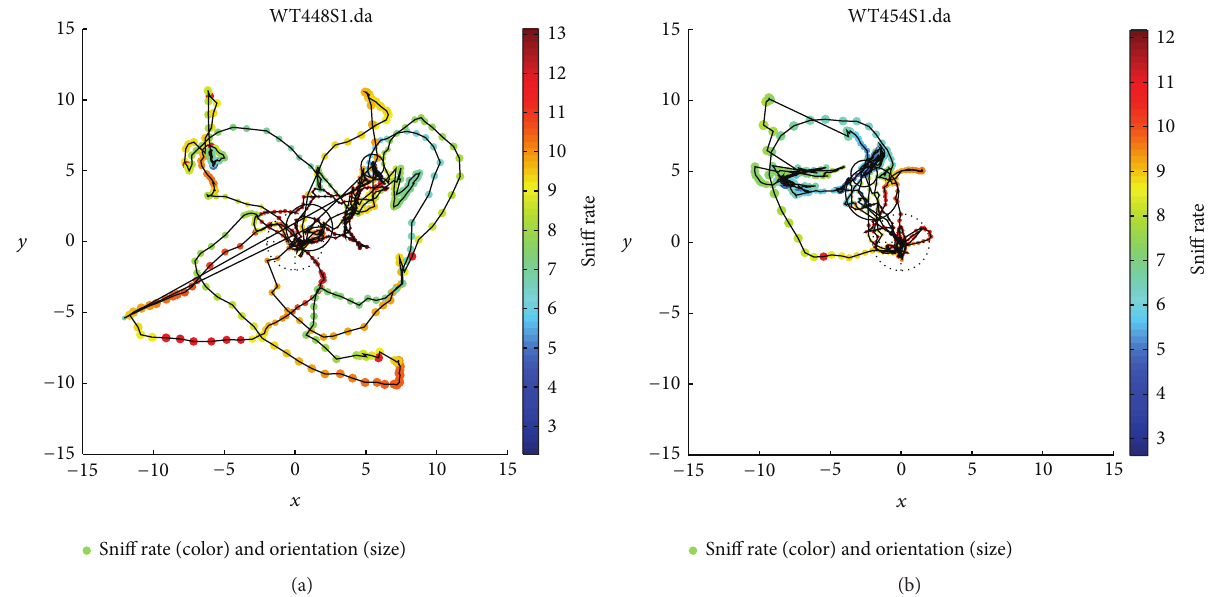
Figure 3: HaXha maps show sniffing rate related to proximity and orientation. Two S1 cross-habituation trials (first presentation of social odor) are represented by plotting the 𝑥 and 𝑦 nose location (circle), orientation (circle size), and sniff rate (circle color, see color bar legend, Hz) of each WT mouse during each 100ms bin of the 120sec trial. Subsequent bins are connected with lines. Centrally located ( 𝑥 , 𝑦 = 0 , 0 ) bulls-eye indicates the odor source location and 2cm proximity criterion (2cm radius). Large solid circle marks the position at trial start and the small circle the position at the end. Mice tended to sniff faster (more red circles) when closer to and oriented to (smaller circles) the odorant.